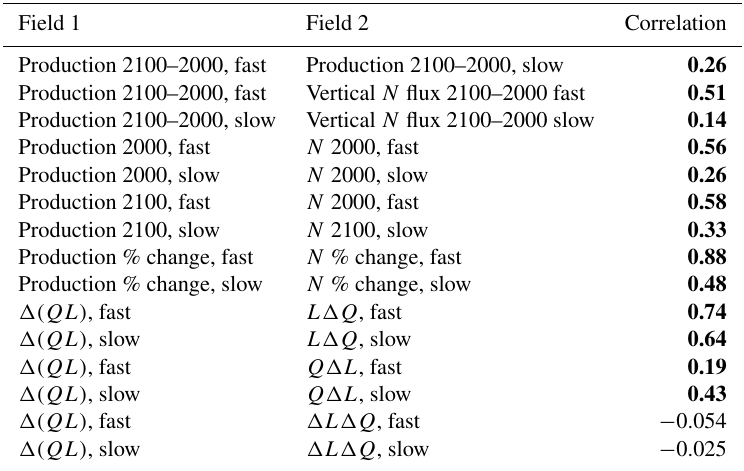
Figure 6. QL for 2000s climate (a, f) , its change (b, g) , and its components, all averaged over 1 year and the top 100m and then normalized by the maximum of QL (nondimensional) in the 2000s. (c, h) L(cid:49)Q , (d, i) Q(cid:49)L , and (e, j) (cid:49)Q(cid:49)L . (a–e) Slow case, normalized by 0.055. (f–j) Fast case, normalized by 0.14. Minima and maxima for each plot are given following the panel letter. Table 2. Pattern correlations for annual-mean fields. Bold values indicate significance. All production, production component, and nutrient concentration ( N ) fields are the mean over the top 100m, and all fluxes are at 100m